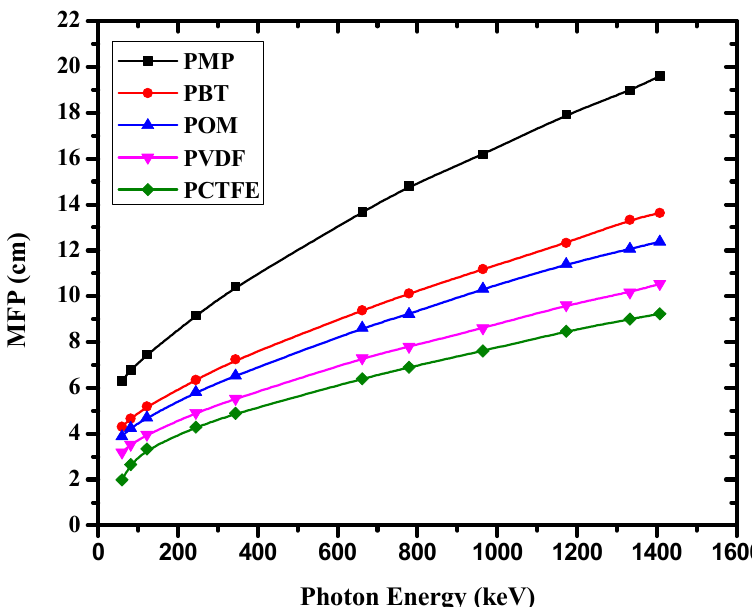
Figure 6. The variation of mean-free path with increasing photon energy for the investigated polymers.